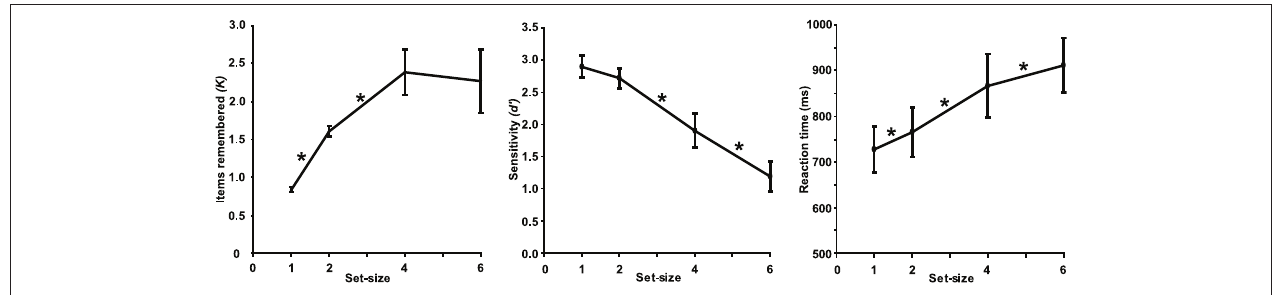
Figure 2 | Mean behavioral performance across subjects. Error bars represent between-subjects 95% confidence intervals. Asterisks indicate significant differences between neighboring set-sizes ( p < 0.05,